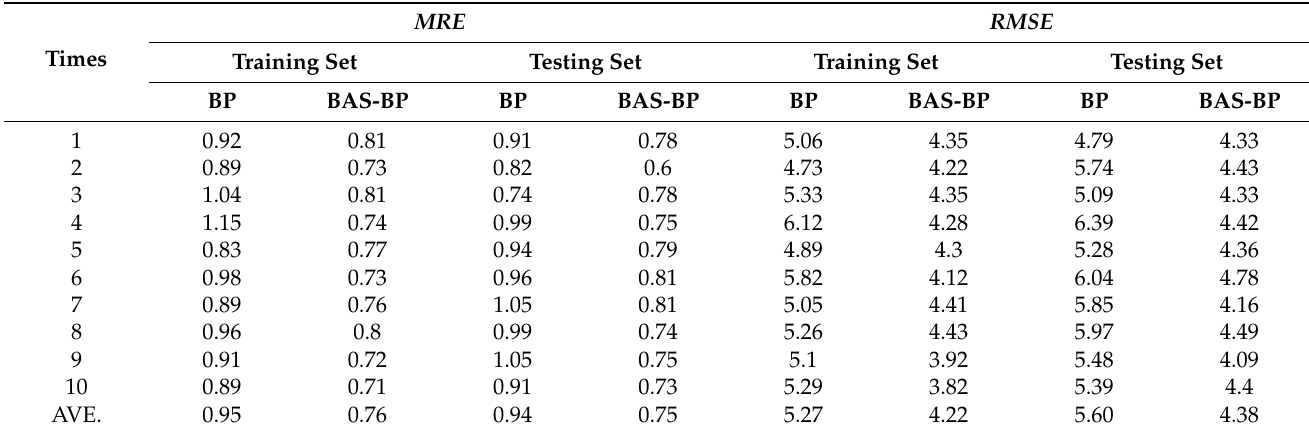
Table 3. Evaluation results of the